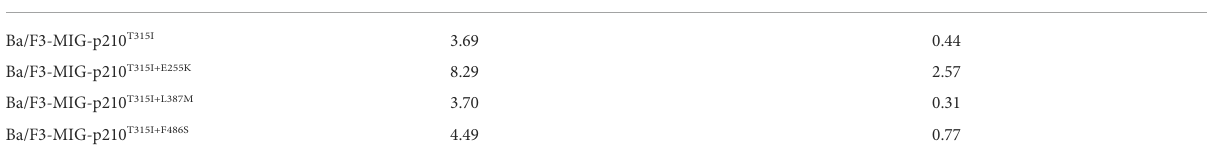
TABLE 2 The IC50 of GMB-475 in Ba/F3 cells with BCR::ABL1